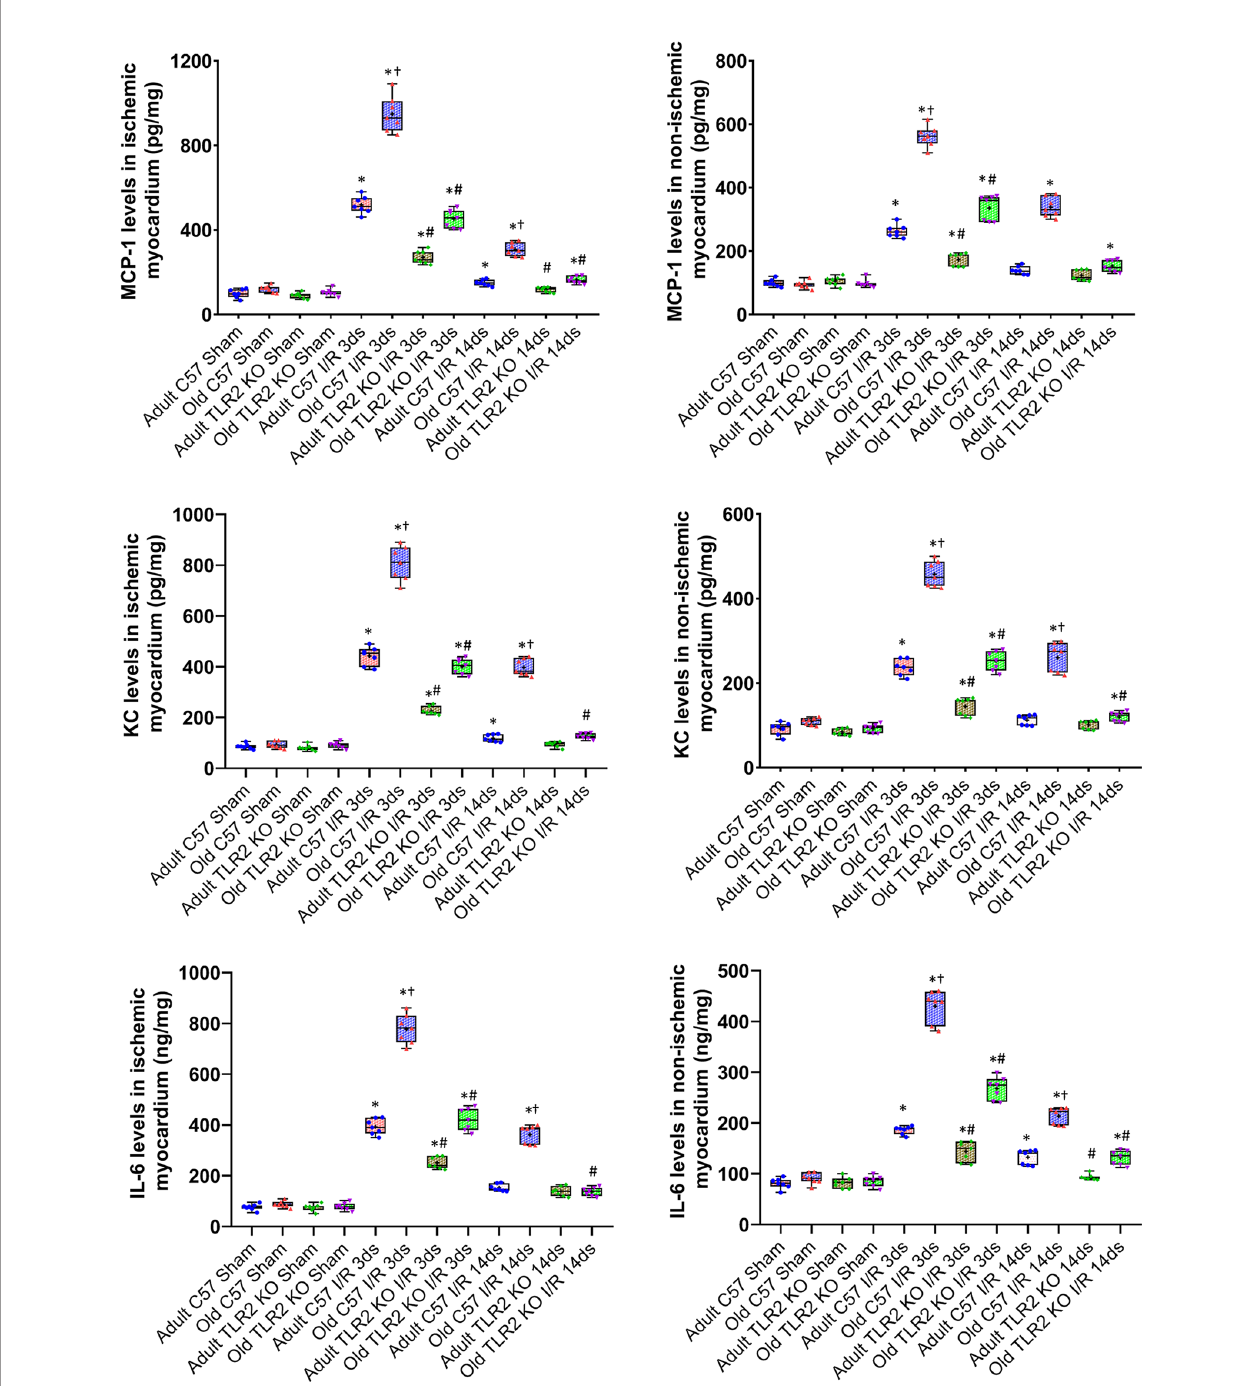
FIGURE 2 | Toll-like receptor (TLR) 2 knockout (KO) has a greater impact on myocardial expression of cytokines in old mice. Myocardial levels of monocyte chemoattractant protein (MCP)-1, keratinocyte chemoattractant (KC), and interleukin (IL)-6 were analyzed at day 3 and 14 of reperfusion after myocardial ischemia with 30 minutes of left anterior descending artery occlusion. TLR2 KO reduced cytokine levels in both ischemic (left column) and non-ischemic (right column) myocardium of adult and old mice, but with a greater reduction in old mice. Data are presented as box-and-whiskers plots; the upper and lower borders of the box represent the upper and lower quartiles; the upper and lower whiskers represent the maximum and minimum values of non-outliers; the horizontal line inside the box represents the median, and the + sign represents the mean. N = 7 in each group, *P < 0.05 vs. combined sham controls (3 and 14 days after ischemia), † P < 0.05 vs. C57BL/6 wild type adult mice, # P < 0.05 vs. the same age of wild type mice at the same time